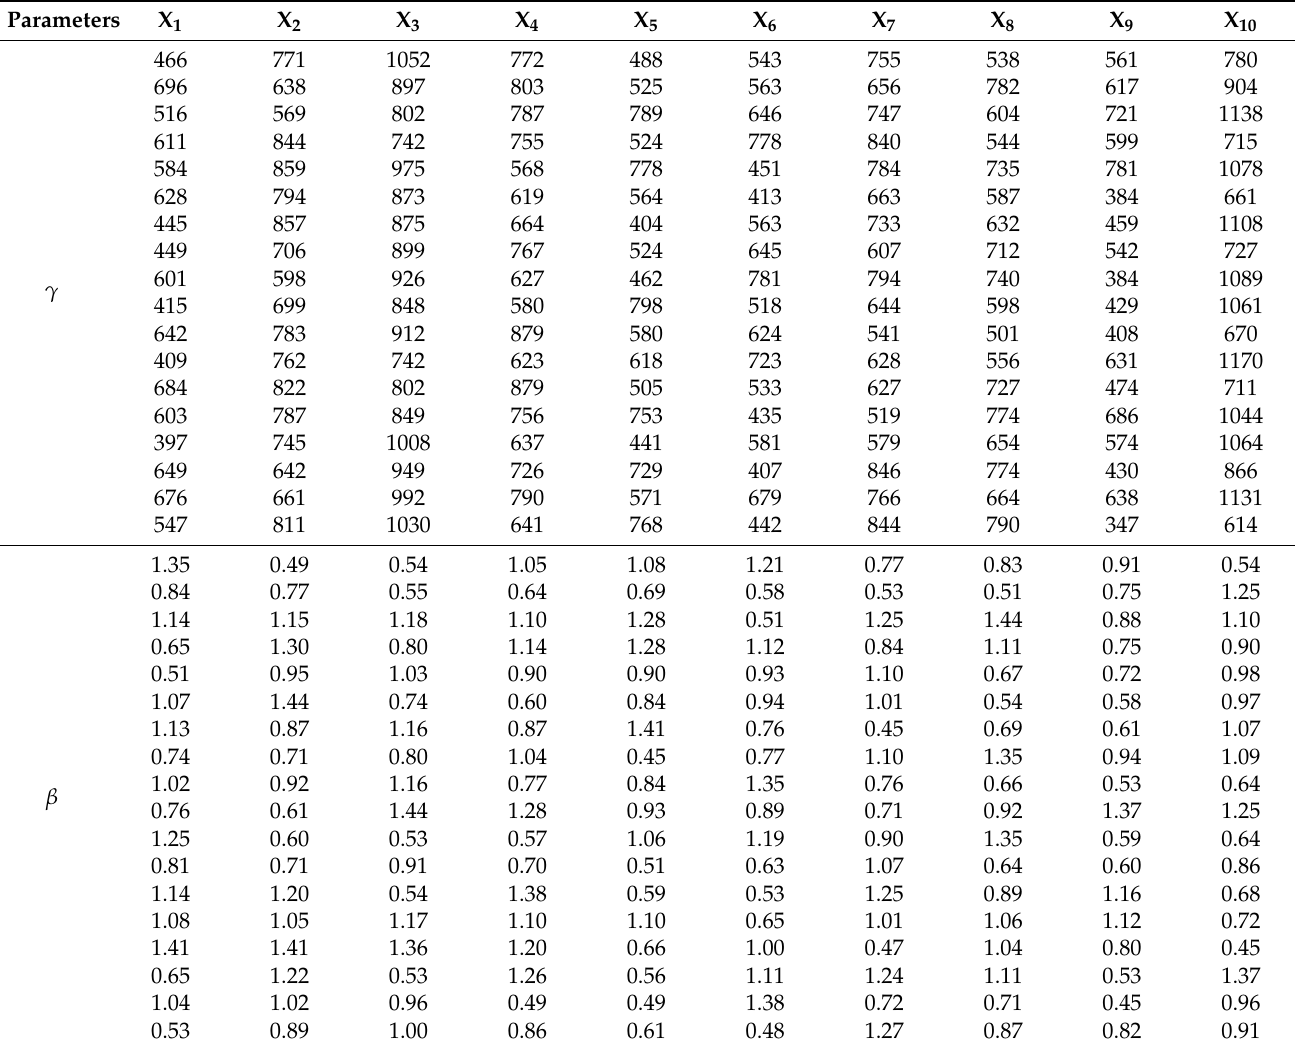
Table 6. The parameters of components in turbine systems.